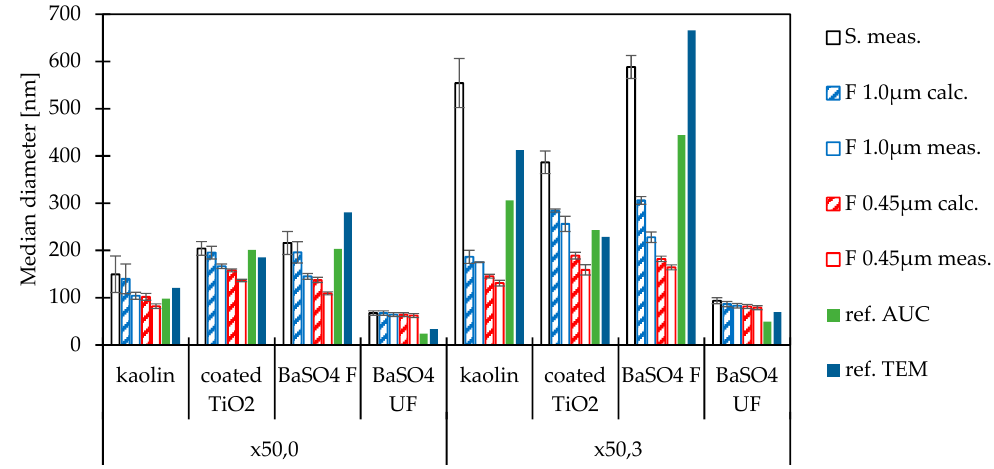
Figure 6. Comparison of measured and calculated median diameters of filtrates with reference diameters from the literature: Volume-weighted median diameter x 50,3 and number-weighted median particle diameter x 50,0 .